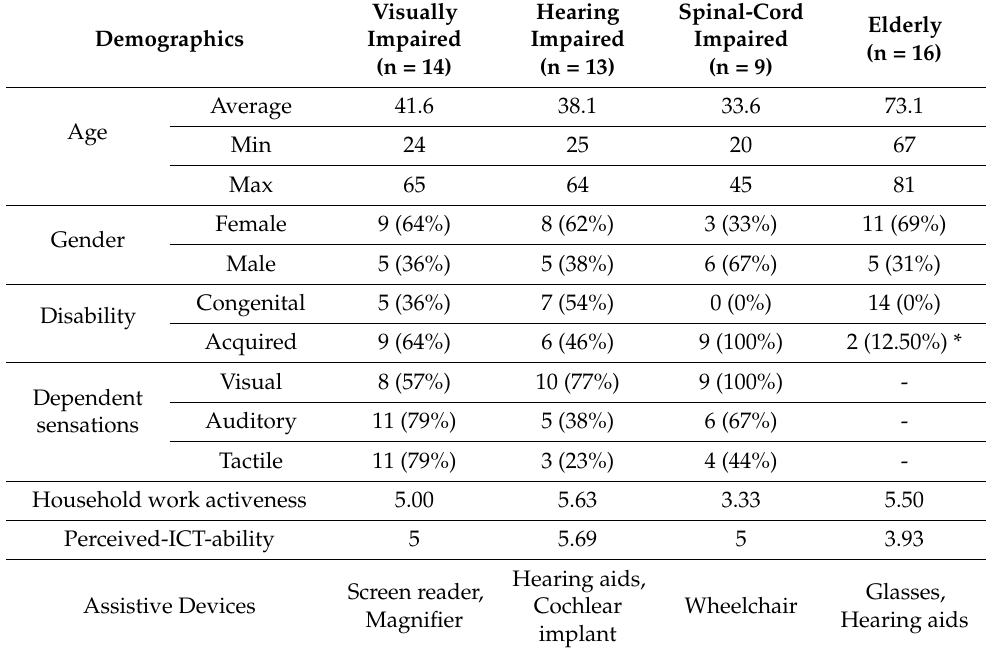
Table 3. Demographics of